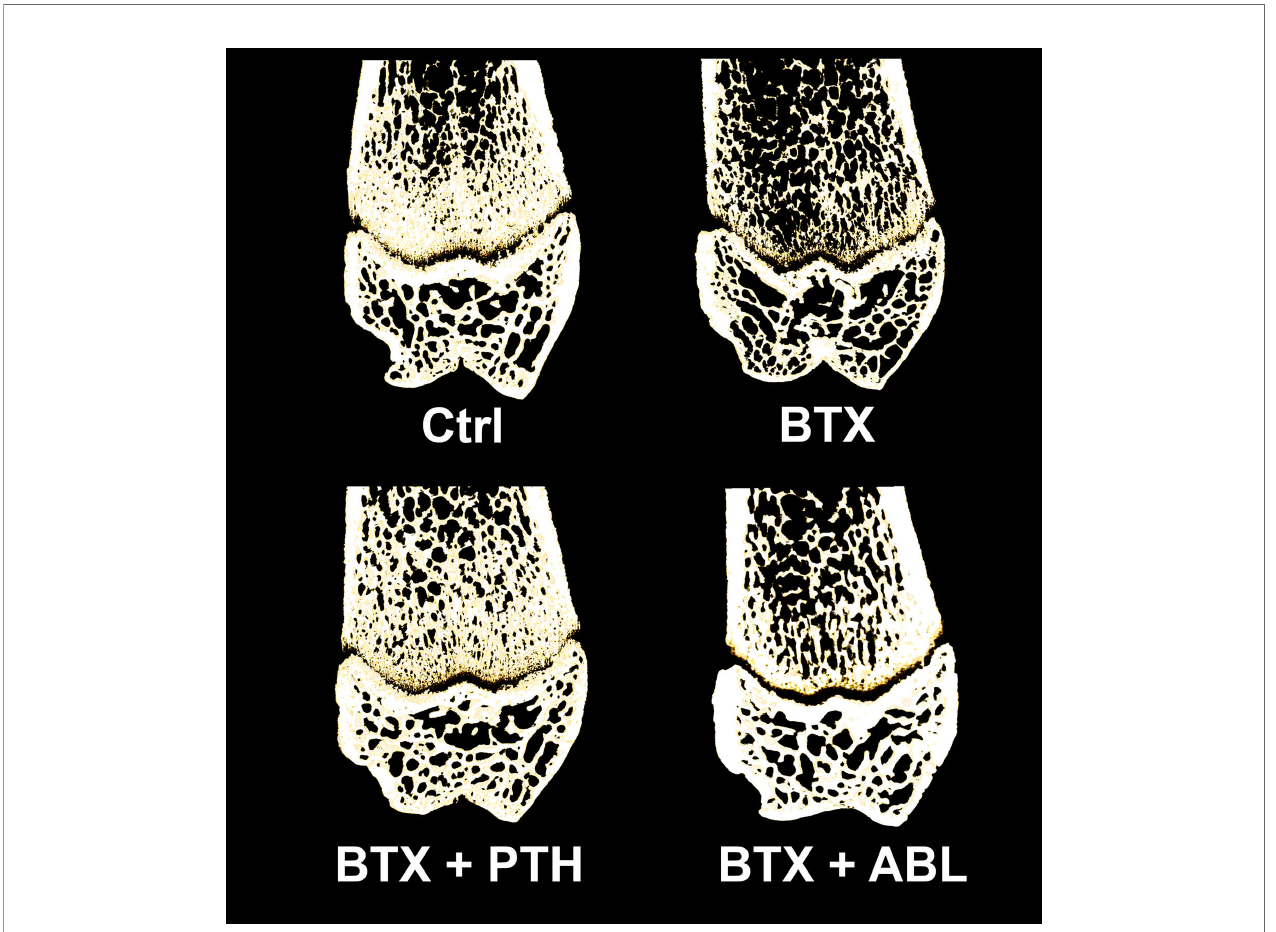
FIGURE 6 | Representative three-dimensional images of a 100- m m-thick slice through the distal femoral metaphysis and epiphysis from rats with the right hindlimb immobilized with BTX and treated with PTH or ABL. Metaphyseal and epiphyseal BV/TV values for the depicted bone samples; Ctrl: 38% and 44%, BTX: 24% and 33%, BTX + PTH: 34% and 41%, BTX + ABL: 31% and 39%, respectively.